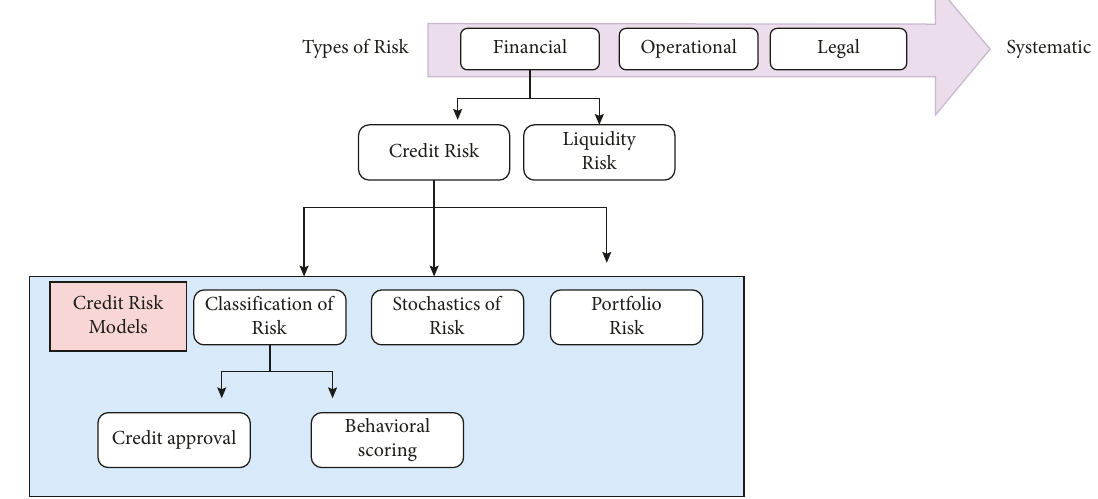
Figure 3: Classification of financial credit risk